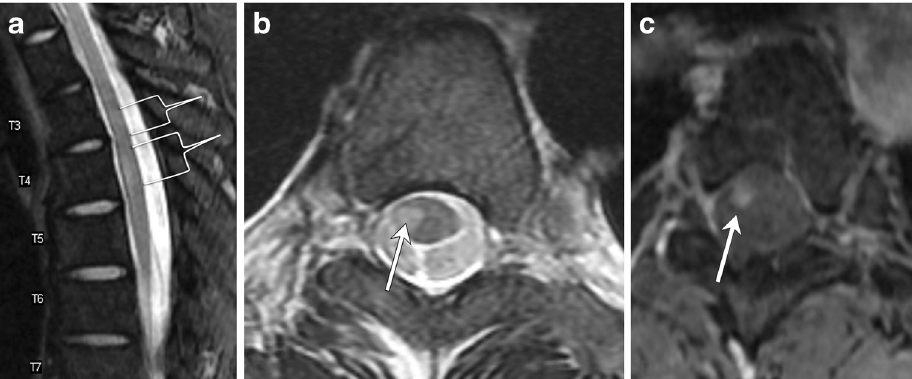
a triangular lesion involving the right lateral cord (arrow). c Axial T1 post-contrast image demonstrates associated enhancement (arrow), con- sistent with active